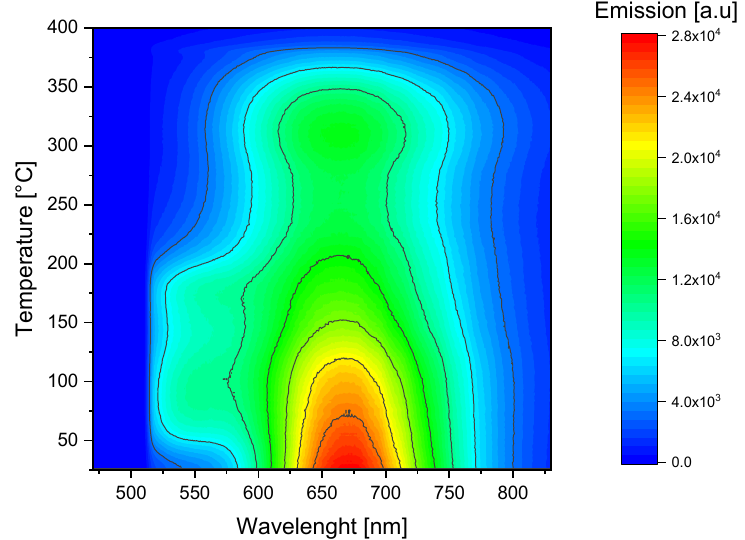
Figure 12. Photoluminescence emission spectra measured while heating the LiF crystal (sample submitted to Method 2). Excitation at 440 nm. The sample was irradiated with 8 kGy of beta radiation from Sr-90/Y-90 source. The spectrum is clipped from the low wavelength side by the applied filter.